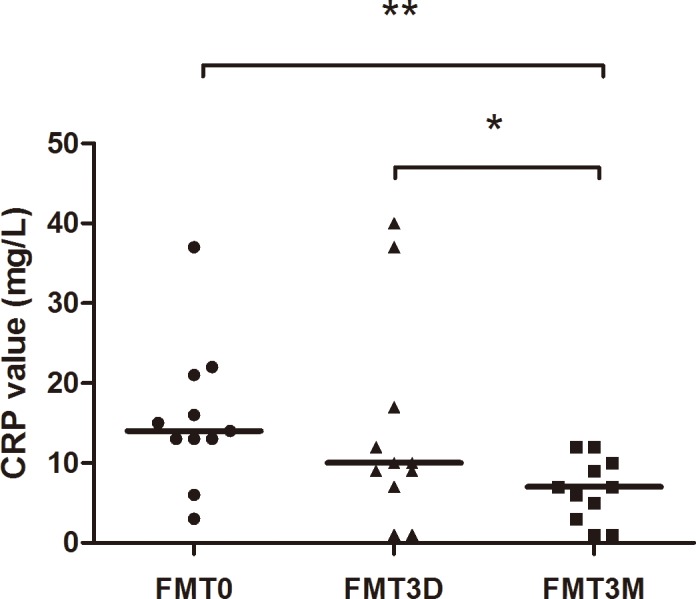
Surveillance of CRP in response group (n = 11).There is no statistical difference on CRP levels in pre-FMT and three days post-FMT. Compared with the value pre-FMT and three days post-FMT, the level of CRP decreased three months post-FMT, ** p<0.01 and * p<0.05, respectively. FMT0: 0 day pre-FMT, FMT3D: three days post-FMT, FMT3M: three months post-FMT.